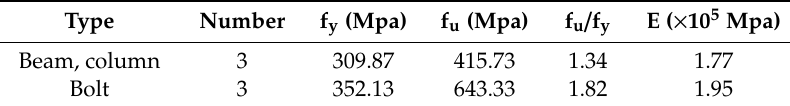
Figure 8. Object picture and dimension drawing of components. ( a ) Special bolt ( b ) base plate ( c ) twisting tool ( d ) upper-end plate ( e ) bottom-end plate ( f ) diagonal stiffener of S1 and S2. Table 1. Results of the material test.